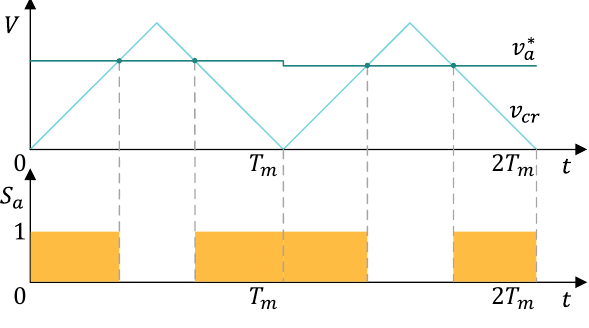
Figure 4. Behavior of a CB-PWM stage in a single